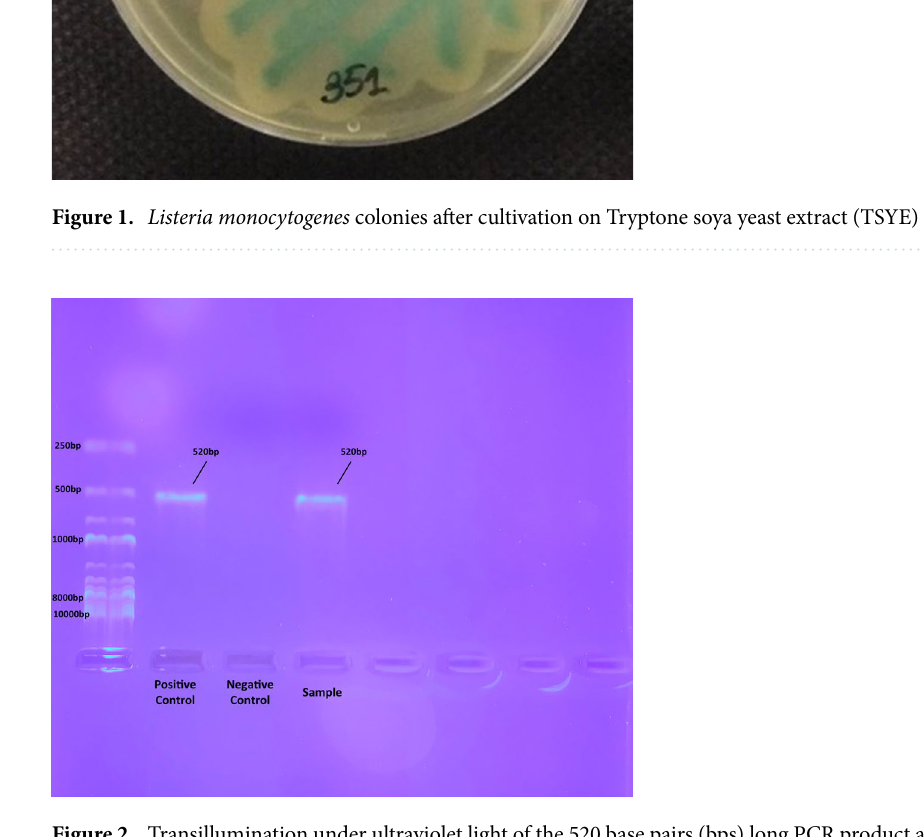
Figure 2. Transillumination under ultraviolet light of the 520 base pairs (bps) long PCR product after agarose gel electrophoresis and ethidium bromide staining, confirming the presence of Listeria monocytogenes on Dermanyssus gallinae . The sampled DNA was extracted from bacterial colonies grown in TSYE agar, and the primers used targeted the hly gene that encodes the Listeriolysin O protein. Abbreviations: PCR, Polymerase chain reaction; TSYE, Tryptone soya yeast